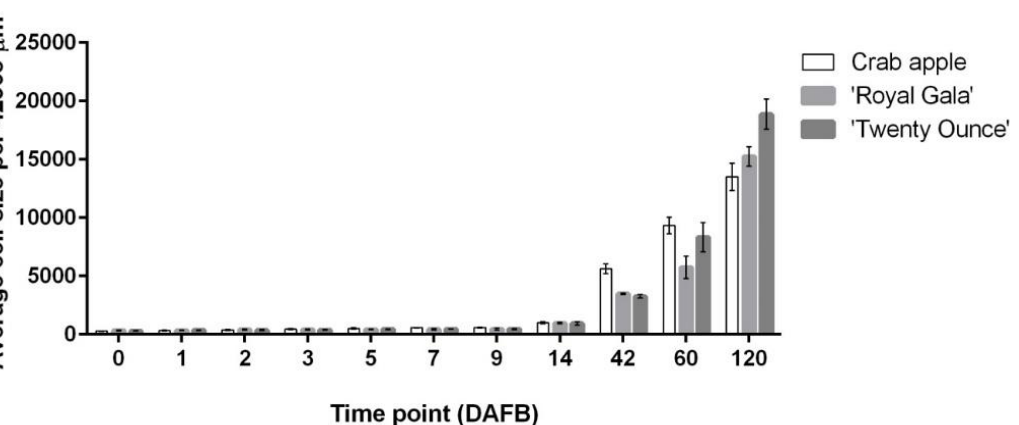
Figure 3. Average cell size of three cultivars from three individual replicates (Season 2). Error bars represent standard deviations. The difference in measurements between cultivars at 42 until 120 DAFB was statistically different (Tukey’s HSD), ANOVA (two-factor), p ≤ 0.05. Crabapples Royal Gala Twenty Ounce